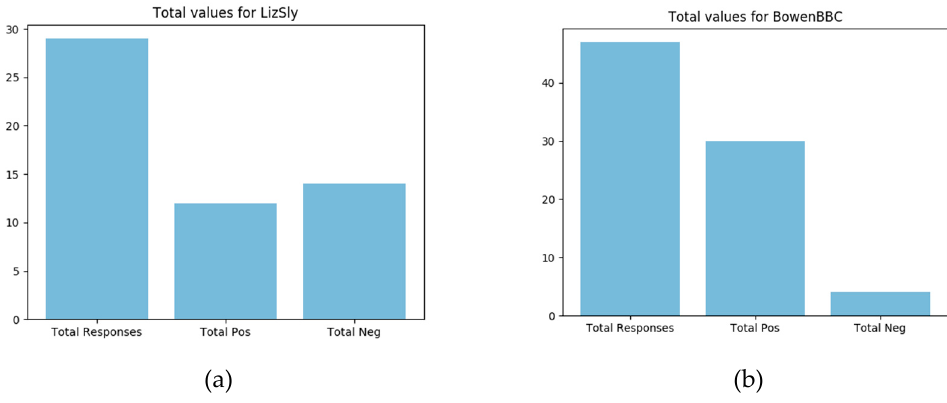
Figure 4. Total values for: ( a ) LizSly; ( b ) Jeremy Bowen.